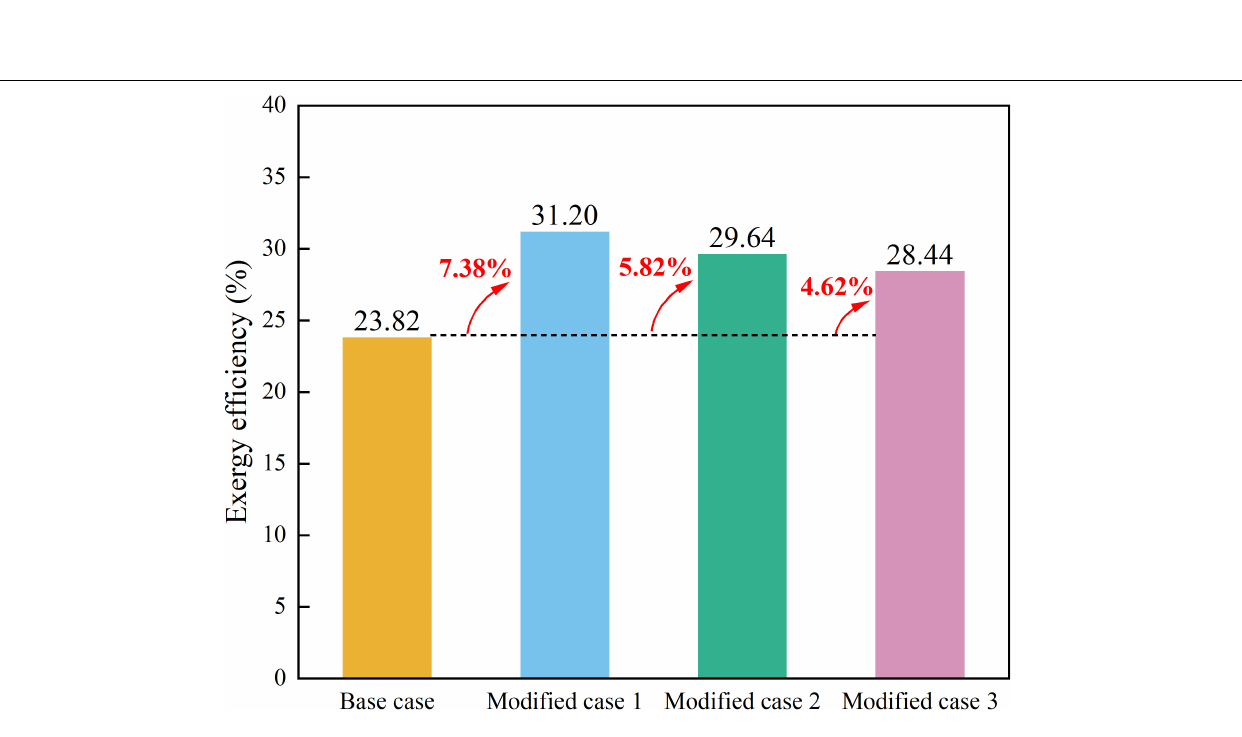
FIGURE 7 | Exergy efficiencies of four